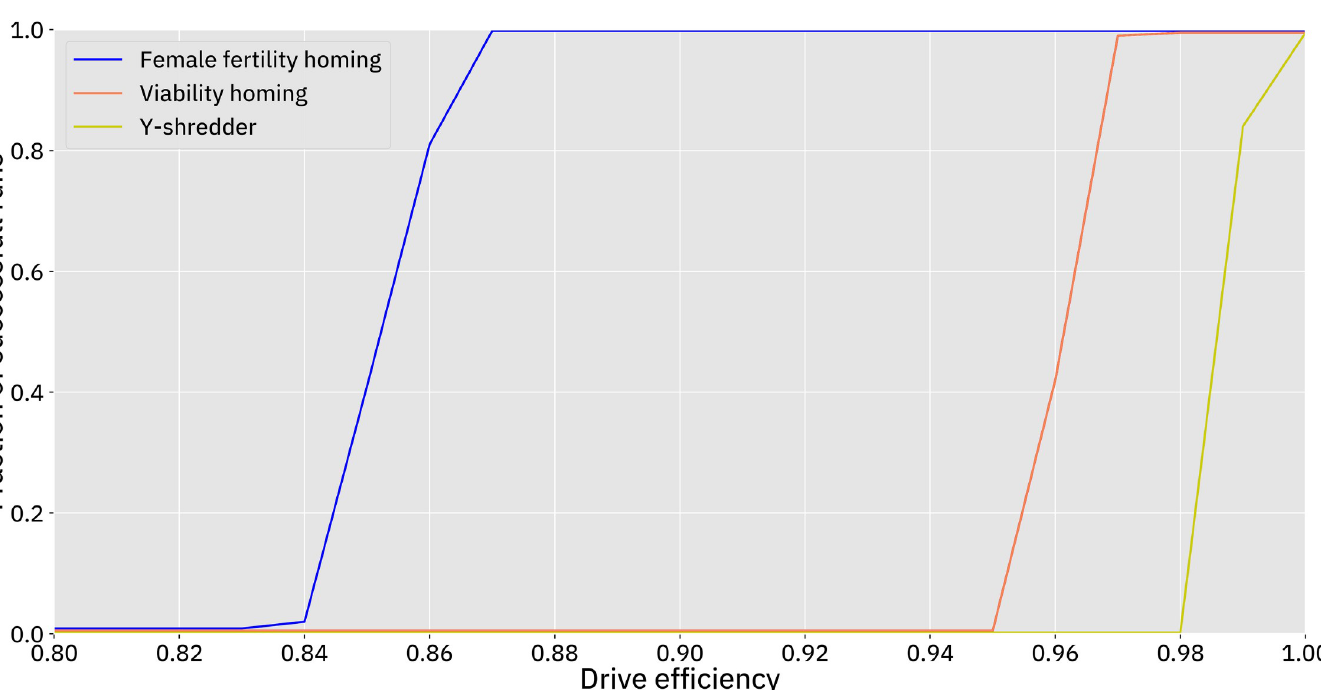
Fig 3. Drive efficiency required to eliminate the population using the default model. Drive efficiency was varied in 1% increments, leaving other parameters at default values, with 100 simulations conducted at each point. A “successful run” is defined as a simulation in which the population is completely eliminated within 500 time steps.